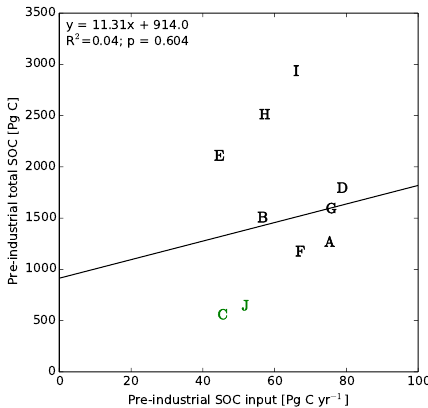
Figure 4. Relationship between pre-industrial global SOC turnover time and total SOC. Letters correspond to the same models as in Ta- ble 1 and models in green (i.e. C and J) integrate nitrogen limitation. The solid line is a linear relationship constructed using all models with equation, R 2 and p values indicated in the top left